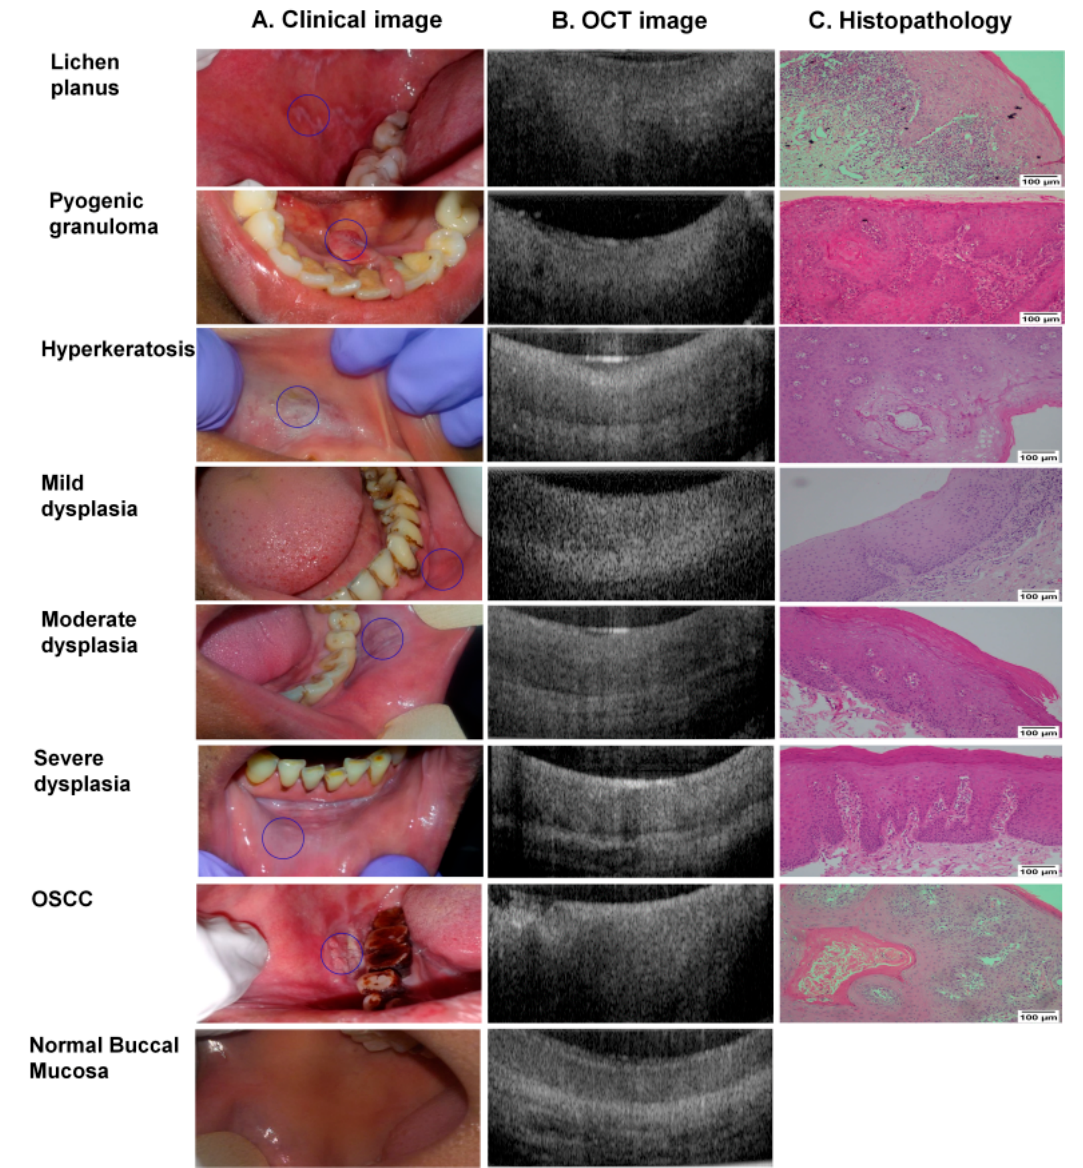
Figure 3. Clinical, OCT & histology images. Clinical ( A ) and OCT ( B ) images were captured for all the subjects and the biopsy tissues collected (wherever indicated) were assessed by histopathology ( C ). Histology images were taken at 100 × resolution (scale bar = 100 µ m) using Nikon DSFi2 and NIS elements D4 20.0. The non-dysplastic lesions shown were histologically diagnosed with lichen planus, pyogenic granuloma, and hyperkeratosis. Normal buccal mucosa images were taken from healthy volunteer without any habit history. Representative images of all dysplastic grades and a buccal oral squamous cell carcinoma (OSCC) are also